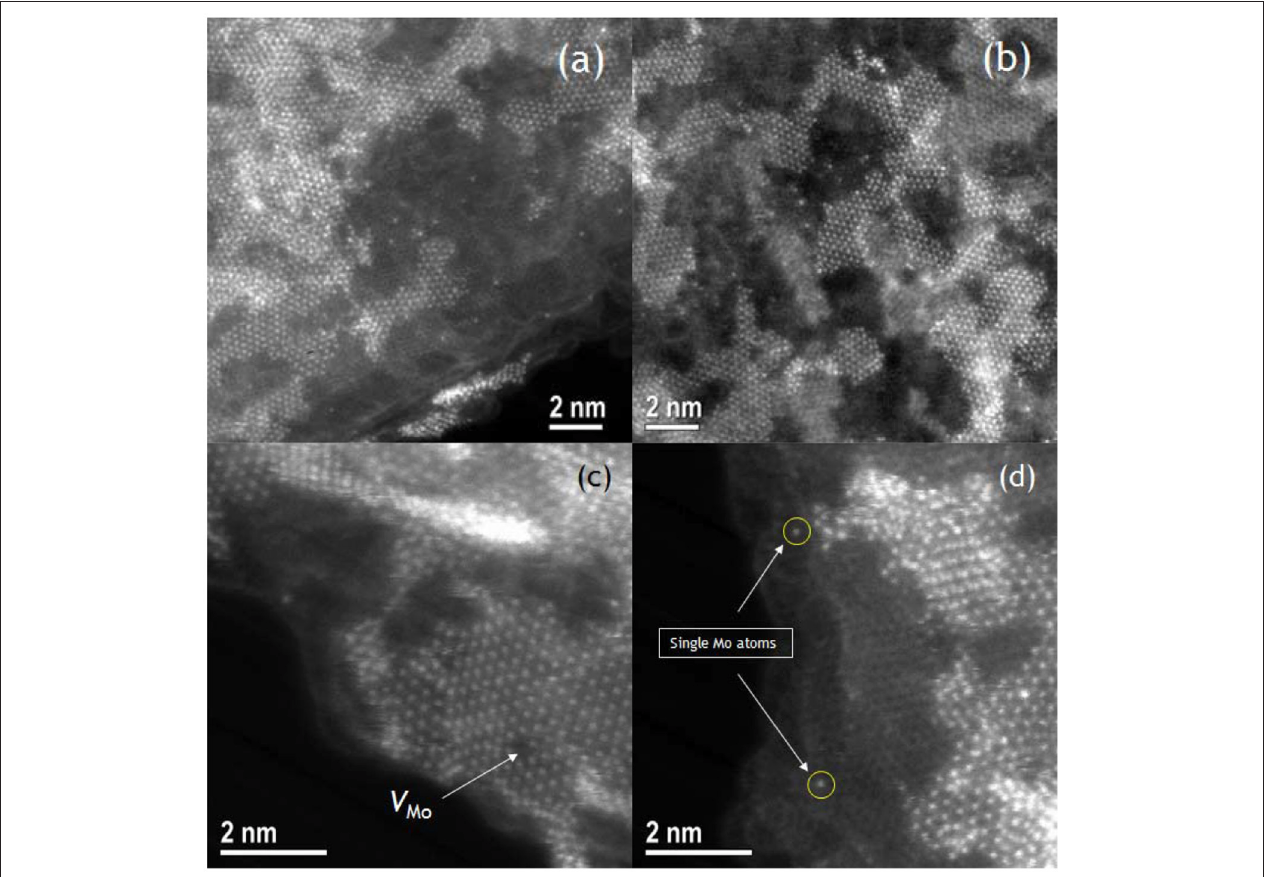
FIGURE 1 | Z-contrast STEM images of the MoS 2 flakes grown on few-layer r-GO.